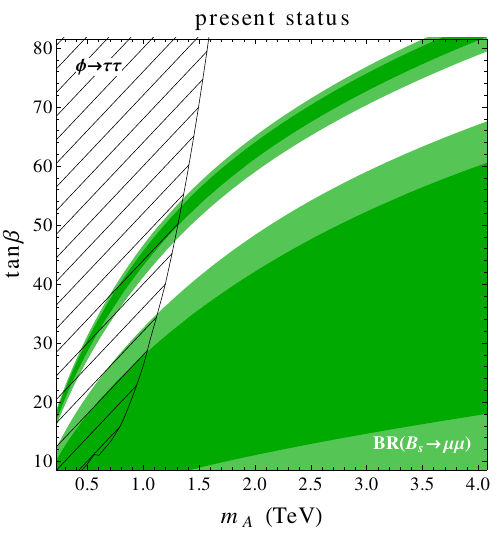
Figure 5 . Current constraints in the m A - tan (cid:12) plane in the MSSM scenario discussed in the text. The dark and light green shaded regions are allowed by the BR( B s (cid:22) + (cid:22) (cid:0) ) measurements at ! the 1 (cid:27) and 2 (cid:27) level. The black hatched region is excluded by direct searches for (cid:28) + (cid:28) (cid:0) resonances. Throughout the plot the light Higgs mass is m h = 125 GeV.